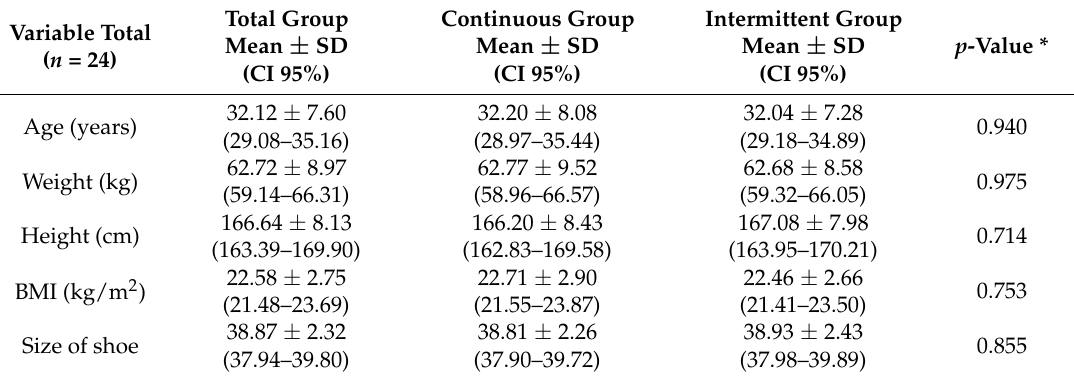
Table 1. Socio-demographic characteristics of the sample